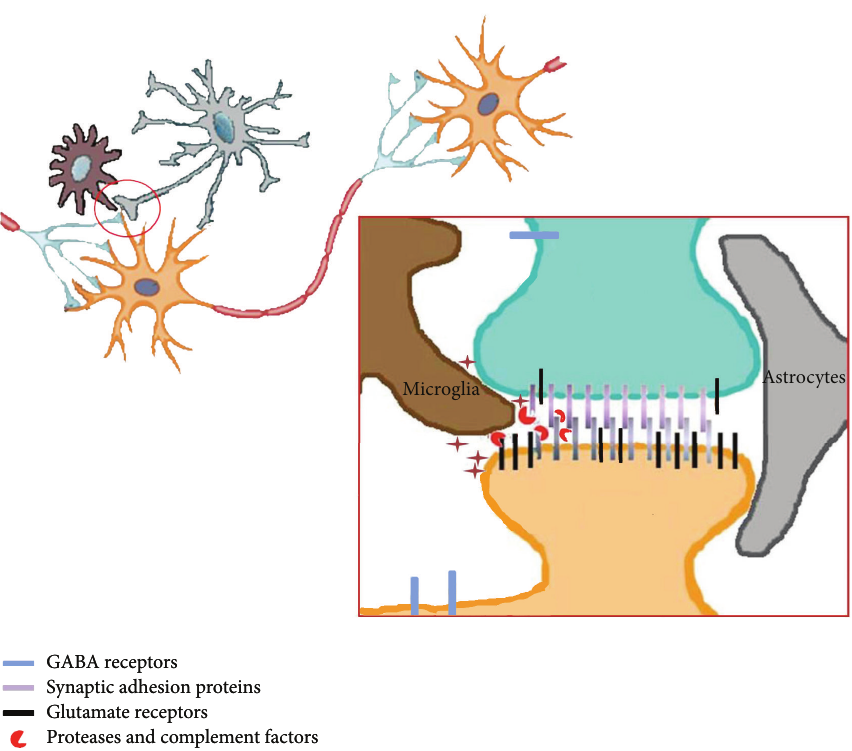
Figure 3: Schematic depicting some of the potential mechanisms through which microglia can affect neuronal activity. Potential interactions between neurons, astrocytes, and microglia at the synapse. The area depicted by the red circle is magnified in inset. Inset: microglial processes in proximity to neuronal synapses can modify neuronal activity via multiple potential pathways. They can secrete proteases to modulate the stability of synaptic adhesion molecules (which in turn influences synaptic transmission) or remove complement-tagged structures. They can release ectosomes that directly interact with the neuronal membranes and initiate signaling cascades. They can also affect directly glutamatergic or GABAergic